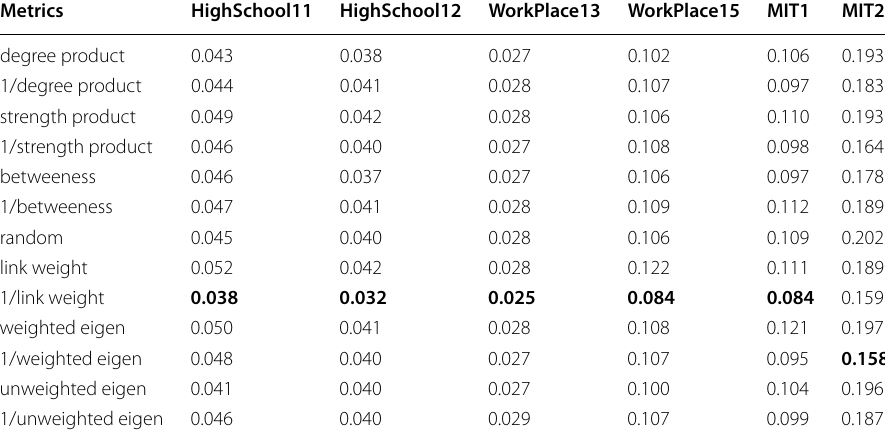
The lowest average prevalence value for each dataset is highlighted in bold